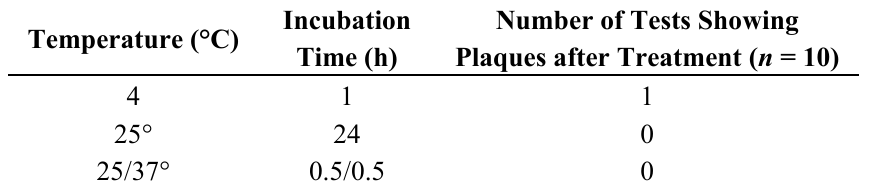
Table 4. Reproducibility of formaldehyde (2%) inactivation of Vaccinia virus . Virus titer was determined by plaque assay. Virus titer prior inactivation was 2.1 × 10 8